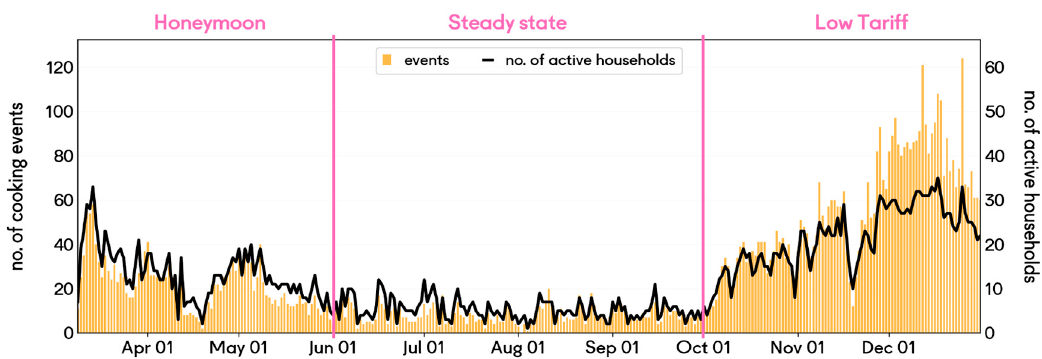
Figure 3. Aggregated cooking events per day and number of households cooking per day. Data from [23], A2EI, 2020.